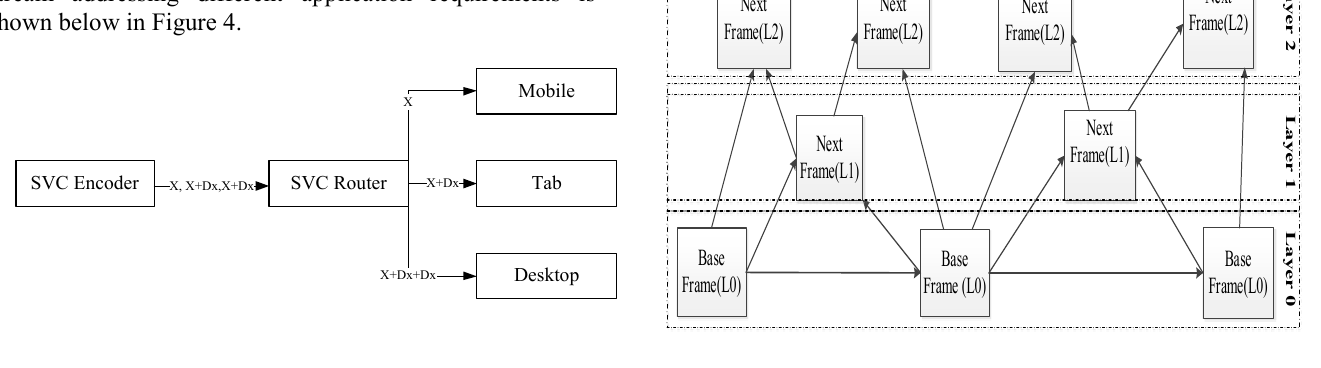
Figure 5. Temporal scalability [3]